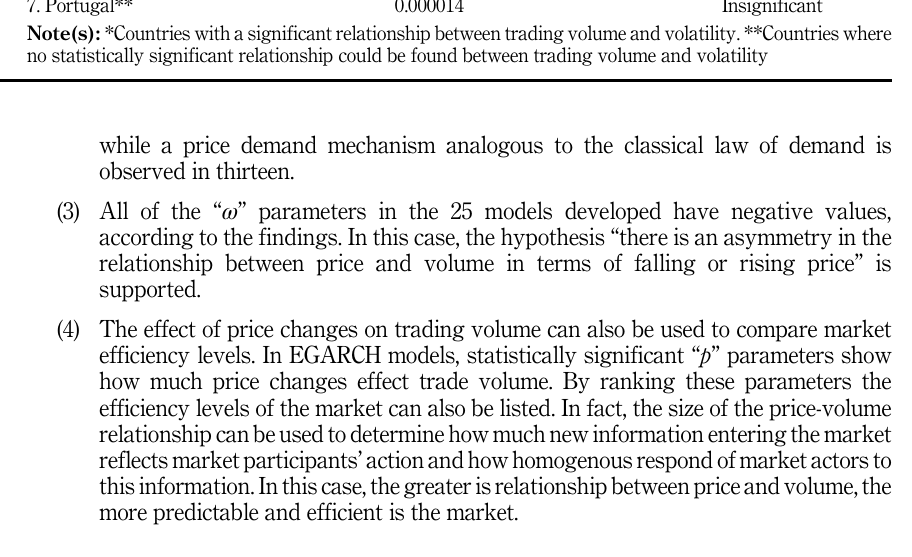
Table 9. Rankings of stock exchange indices with positive relationship between transaction volume and price